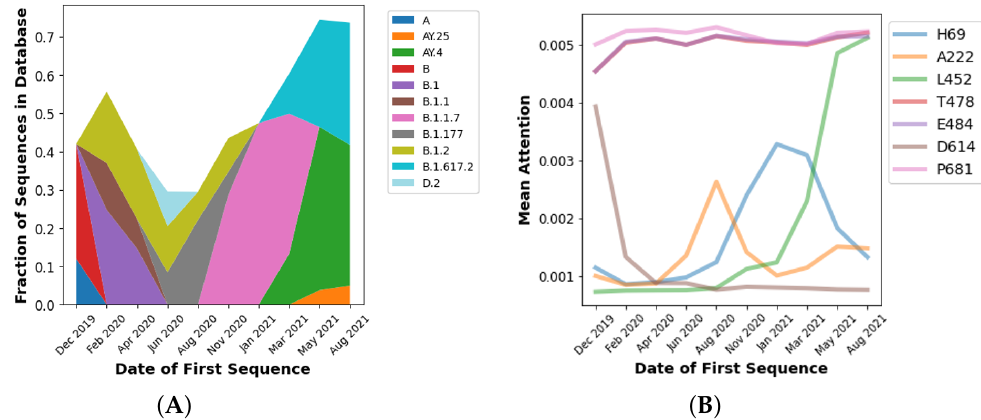
Figure 4. ( A ) Relative prevalence of the three most frequently observed lineages (by sequence) in the 1 October 2021 data set in each time period identified in Figure 3. Because less frequently observed lineages are excluded for clarity, the values sum to less than 100%. ( B ) Mean attention levels for exemplary protein sequence positions with date of first emergence in time periods corresponding to Figure 3. The legend shows the amino acid in the reference (wild type) sequence for each